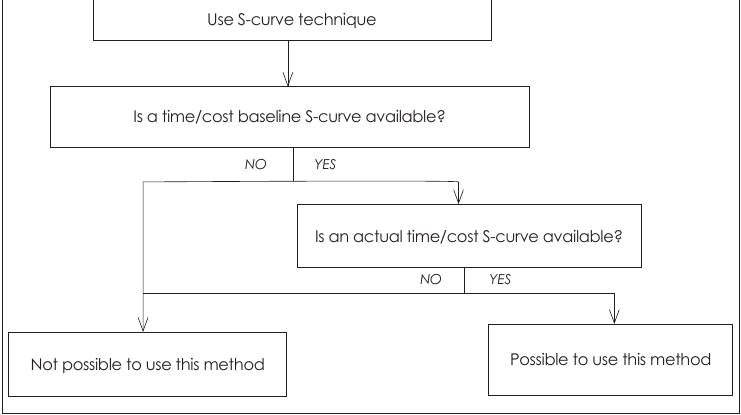
Figure 14: Decision tree: Use S-curve